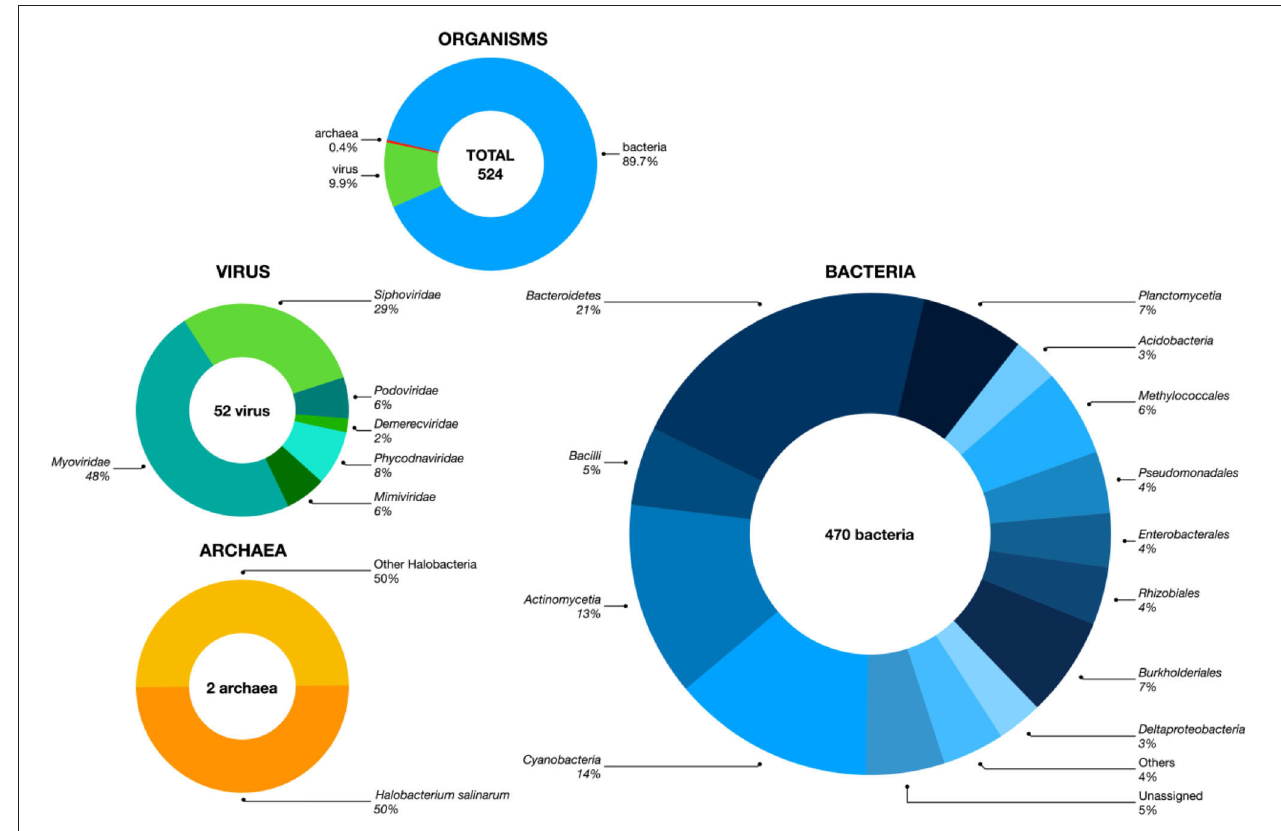
FIGURE 1 | Microbial diversity of the Guarapiranga reservoir. Five hundred twenty-four species were identified in the sample. Bacteria were the most abundant microorganism (470) represented by at least 44 phyla, followed by 52 viruses of at least six families, and two archaea. For a full list see Supplementary File 1